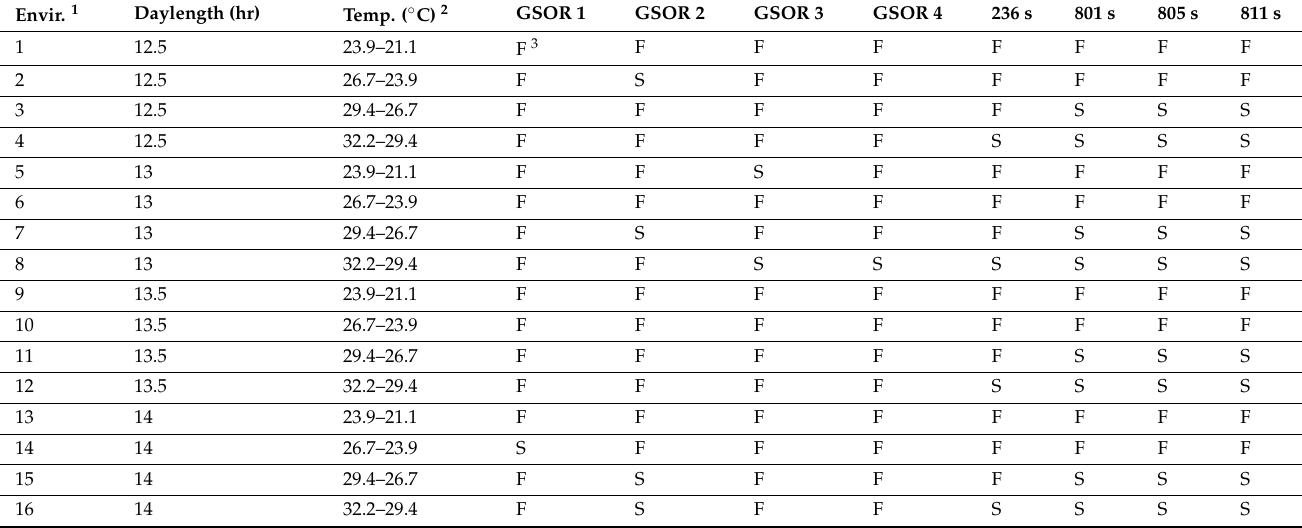
Table 1. Growth chamber results in 2017 (S—sterile) (F—fertile) of 16